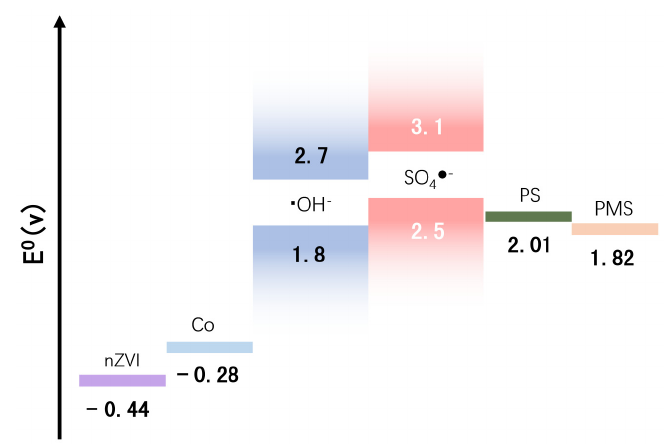
Figure 1. Redox potential of various